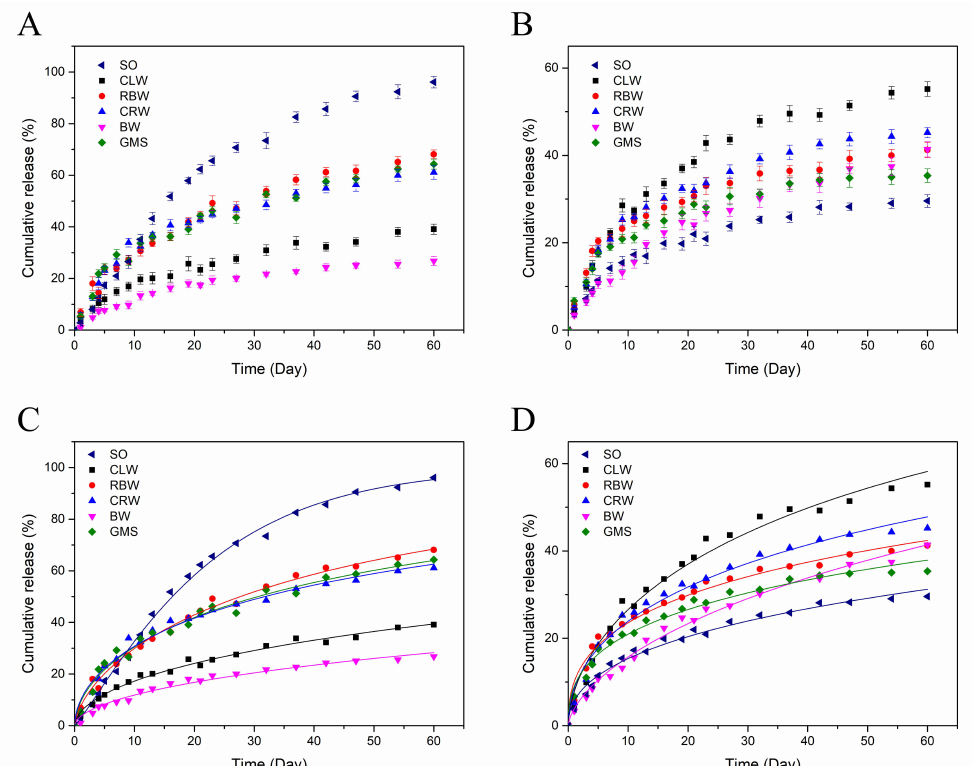
Figure 6. Dynamic release curves of 2-methylpyrazine ( A ) and nonanal ( B ). Weibull model fitting release curves of 2-methylpyrazine ( C ) and nonanal ( D